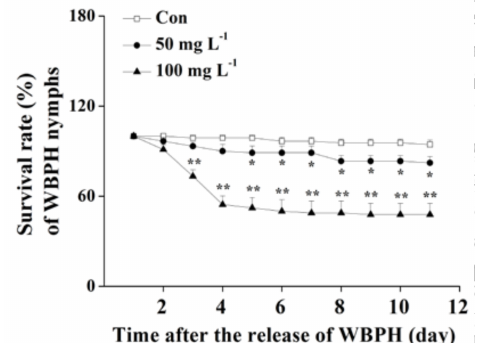
Figure 2. Spraying with bismerthiazol induces resistance of rice to WBPH. Mean survival rates (+SE, n = 6) of 15 newly hatched WBPH nymphs fed on plants that had been individually sprayed with 4 mL of 50 or 100 mg L − 1 bismerthiazol (Bis) or with buffer only (Con) for 24 h, 1–11 days after exposure. Asterisks indicate significant differences in bismerthiazol-treated plants compared with non-treated plants (* p < 0.05; ** p < 0.01; Duncan’s multiple-range test).